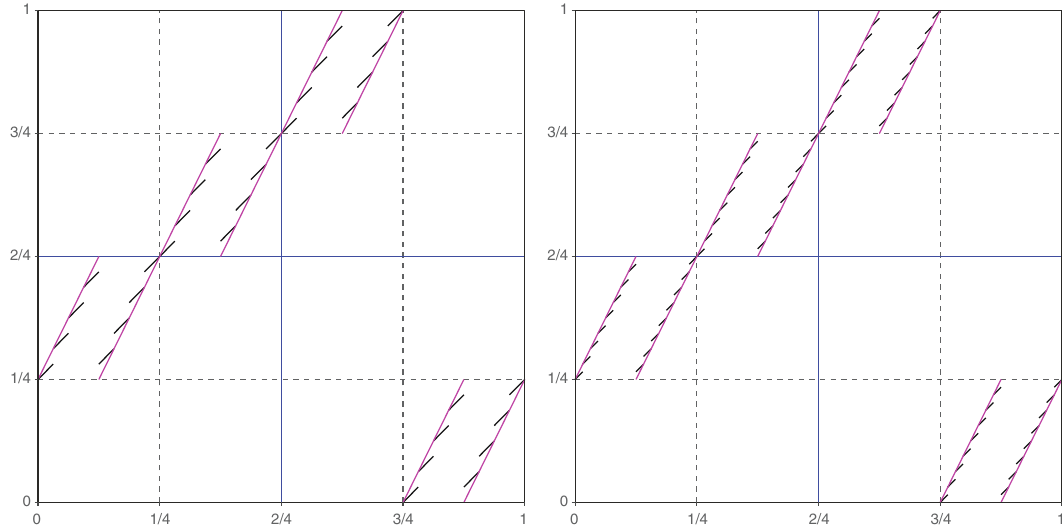
( black ) for n 4 = ( left panel ) and n 8 = ( right panel ) as well as the copula μ C f n (cid:6) ( )